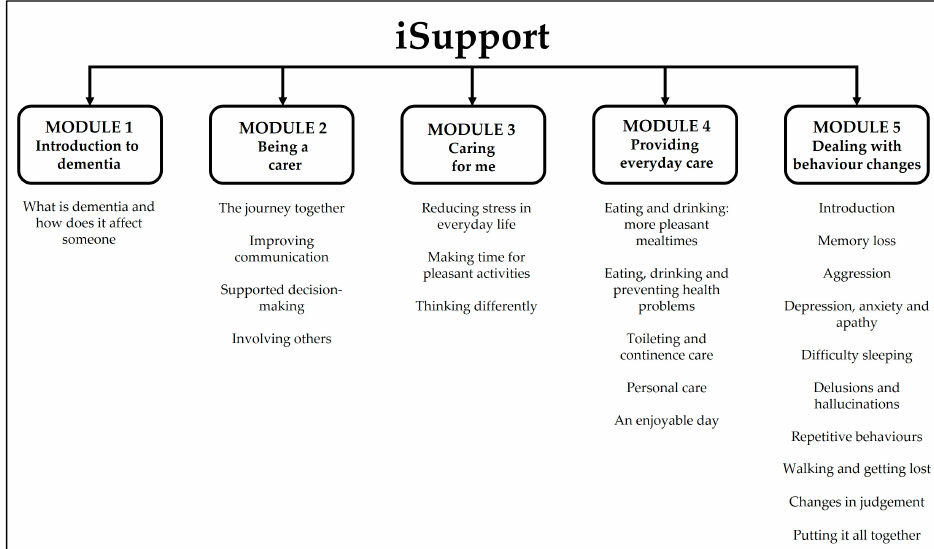
Figure 1. iSupport content.